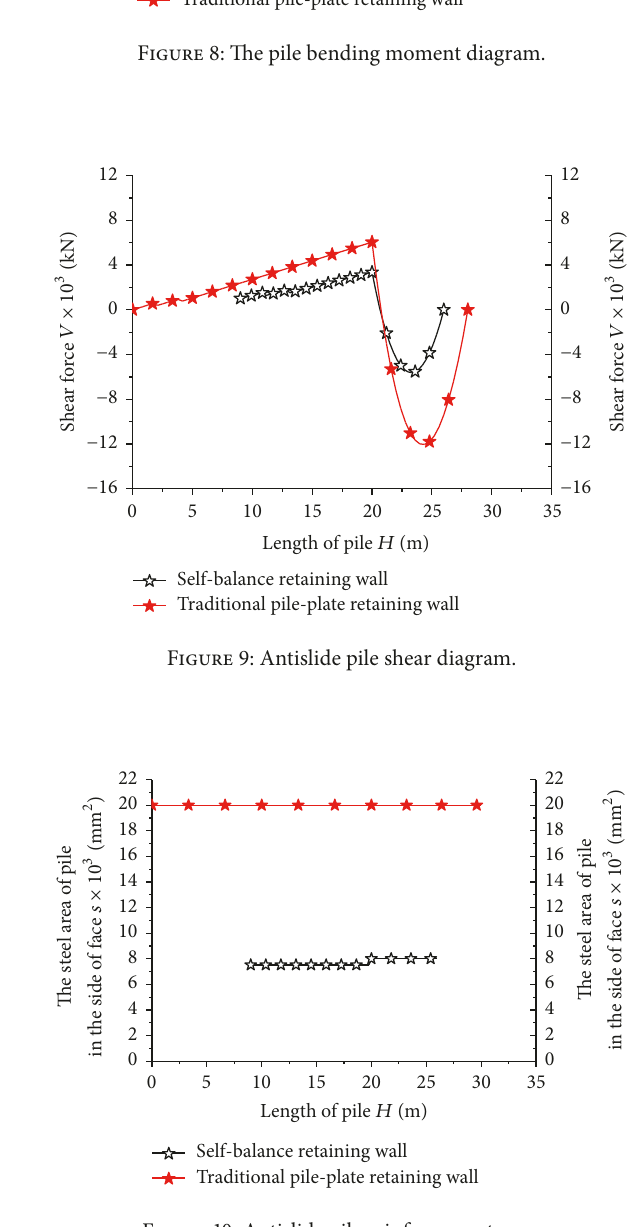
Figure 10: Antislide pile reinforcement